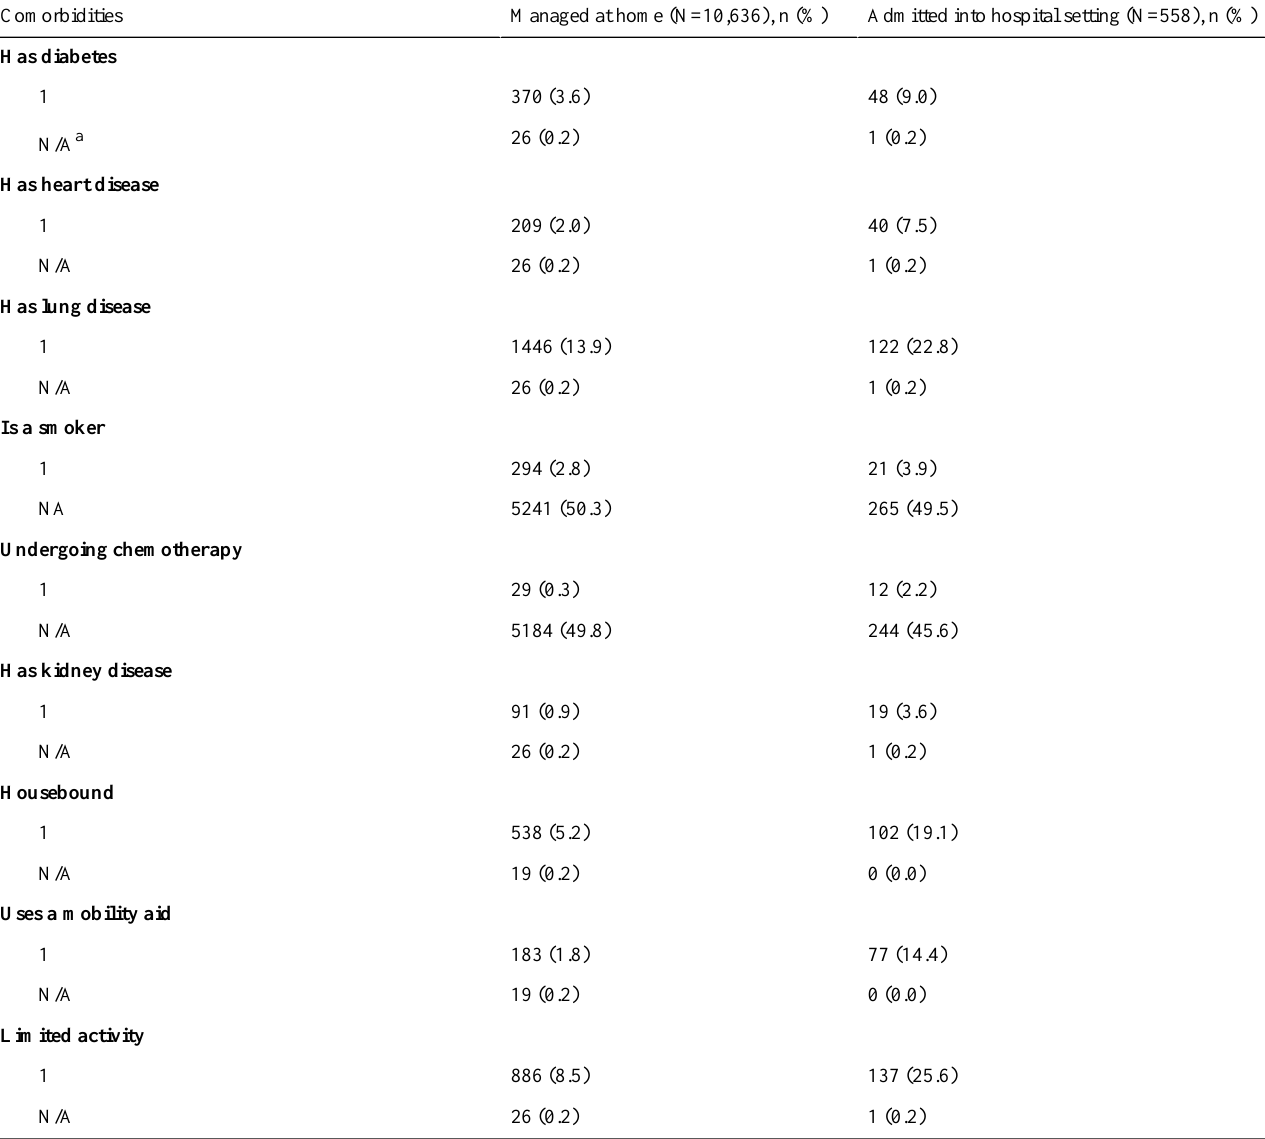
Table 2. Features of comorbidities investigated in relation to whether a user was seeking treatment. All features were